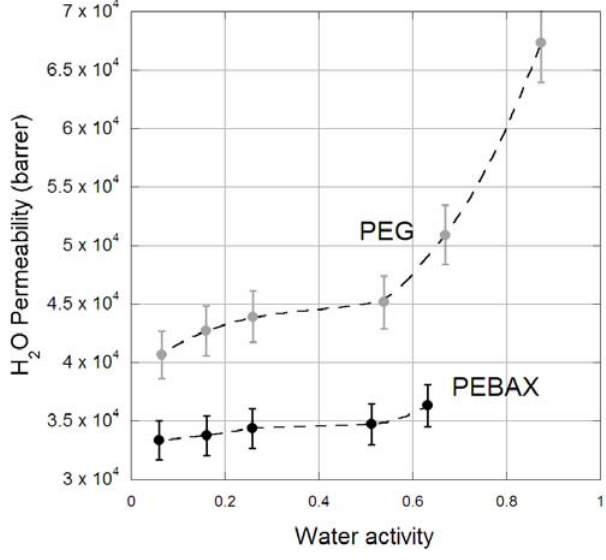
Figure 4. Water Permeability (Barrer) in PEBAX (black) and PEG (grey) membranes within a humidified N 2 feed gas stream.